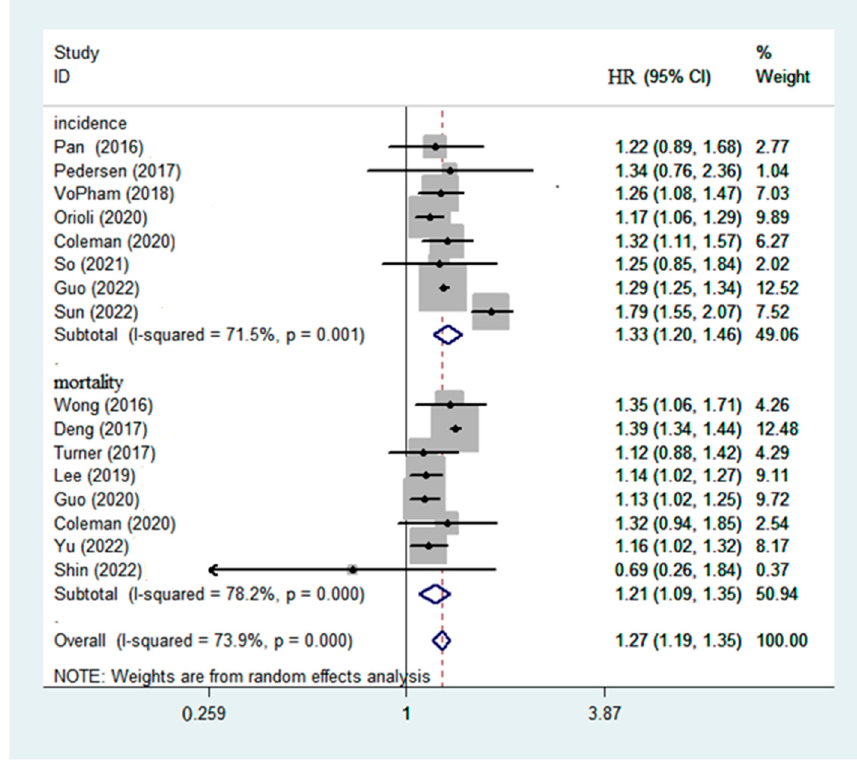
Figure 2. Long-term exposure to fine particulate matter (PM2.5) and risk of chronic liver disease according to in a random-effects meta-analysis. HR, hazard risk; CI, confidence interval (HR and 95% CI are for a 10 μ g/m 3 increase in PM2.5) [23,24,29–42].